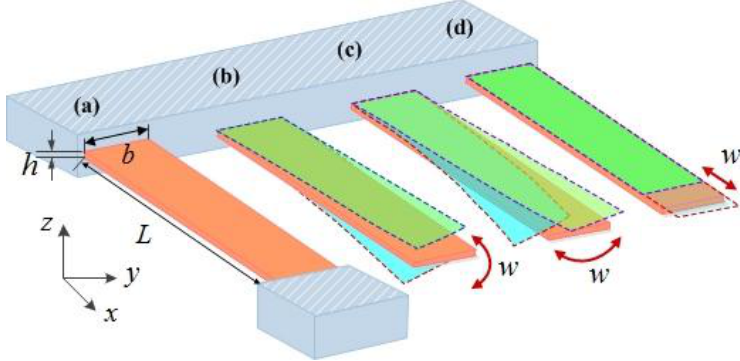
Figure 1. Schematic diagram of the beam-based resonators. Doubly clamped beam ( a ) and cantilever beam with the flexural (out-of-plane) mode ( b ), the lateral (in-plane) bending mode ( c ) and the elongation (in-plane) mode ( d